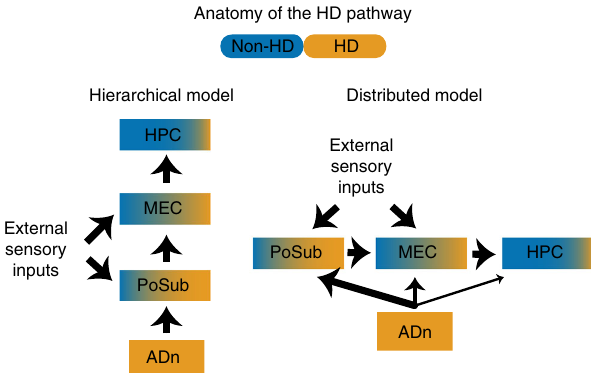
Fig. 5 Anatomical organization of neural information relevant to navigation. Schematic diagram of HD signal transformation to spatial information in a hierarchical (left) or distributed (right)